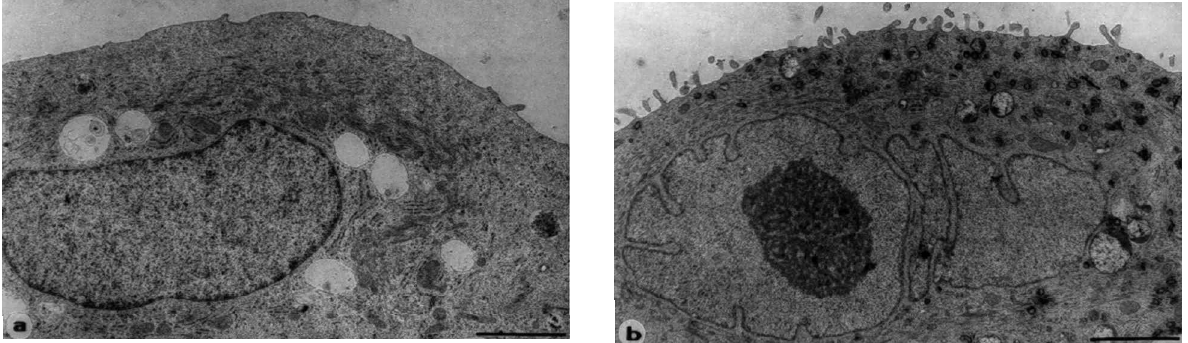
FIG. 3. Transmission electron micrographs of NHBE cells: (a) control, (b) exposed to 2.5 m M poly- L -arginine. Note changes in nucleus. Bar = 2 m